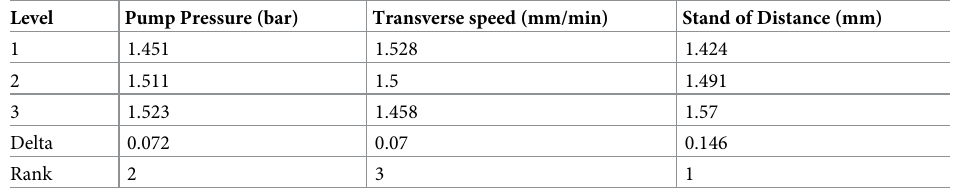
Table 5. Response table of 0.1 wt. % filler loaded